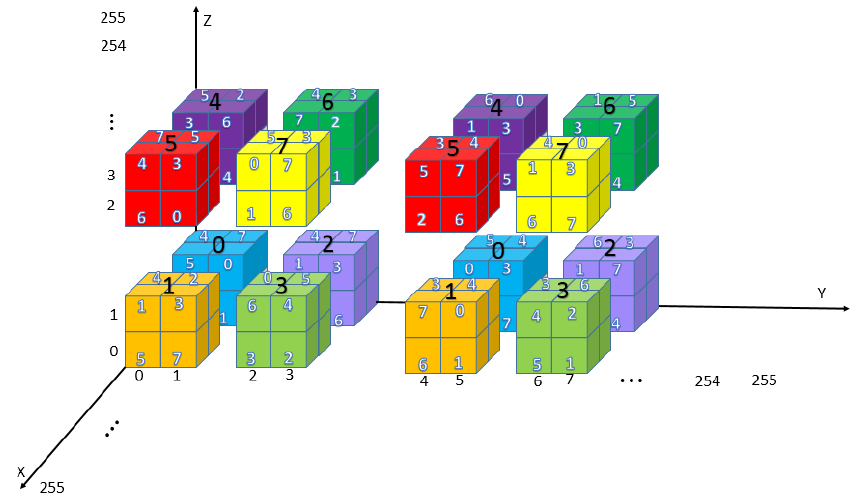
Figure 6. Architecture of cubic matrix.